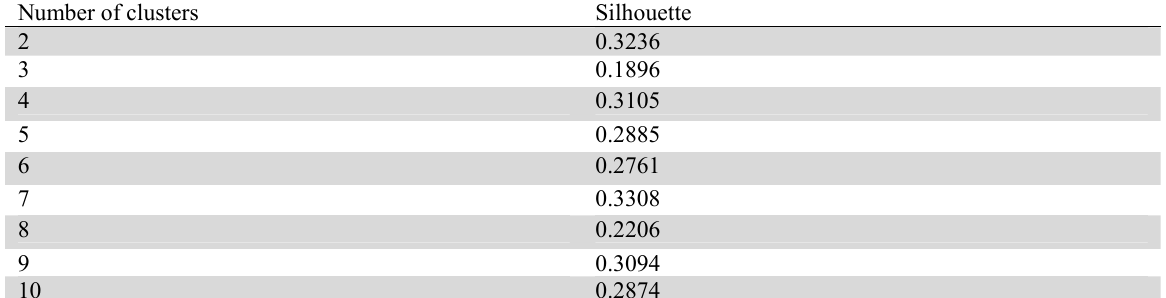
Comparison of the silhouette values for different numbers of clusters in K-means algorithm for scenario 1 in situation 1